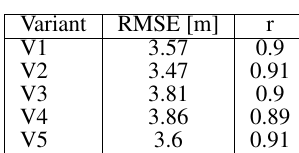
Table 1. Performance comparison of the different candidate H-DSPEB architectures.